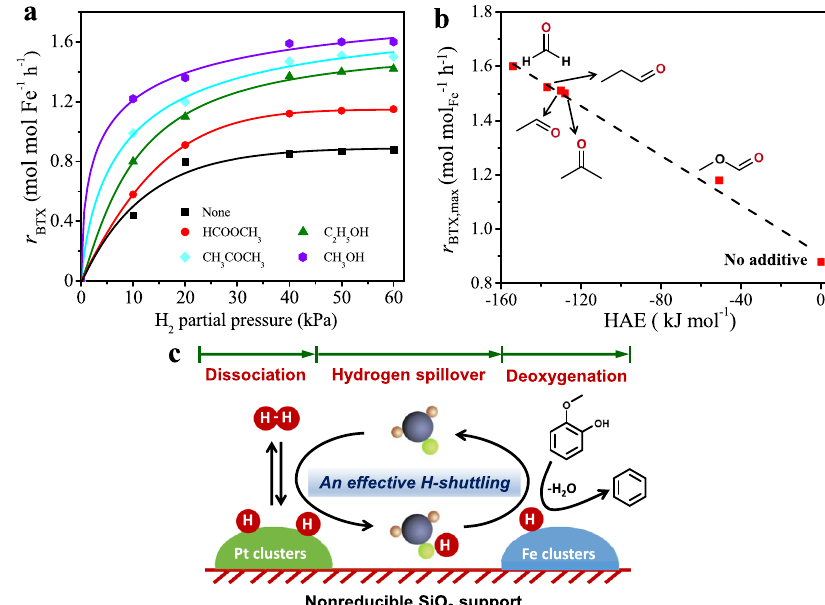
Fig. 7 Promoting effects of gaseous oxygenate additives on BTX formation rates. ( a ) a function of H 2 partial pressure with or without 0.5 kPa oxygenate additive. Reaction condition: 450 °C, 0.5 kPa guaiacol, balanced by N 2 , methanol and ethanol used as the precursors of formaldehyde and acetaldehyde, respectively, 1Pt@-10Fe@SiO 2 as catalyst. Solid curves indicate trends. ( b ) correlation between the maximum r BTX ( r BTX,max ) achieved on 1Pt@-10Fe@SiO 2 and DFT-derived HAE values for various oxygenate additives ( r BTX,max taken from Fig. 7a; HAE taken from Supplementary Fig. 10). ( c ) An illustration of the proposed oxygenate-assisted hydrogen spillover mechanism over the inert SiO 2